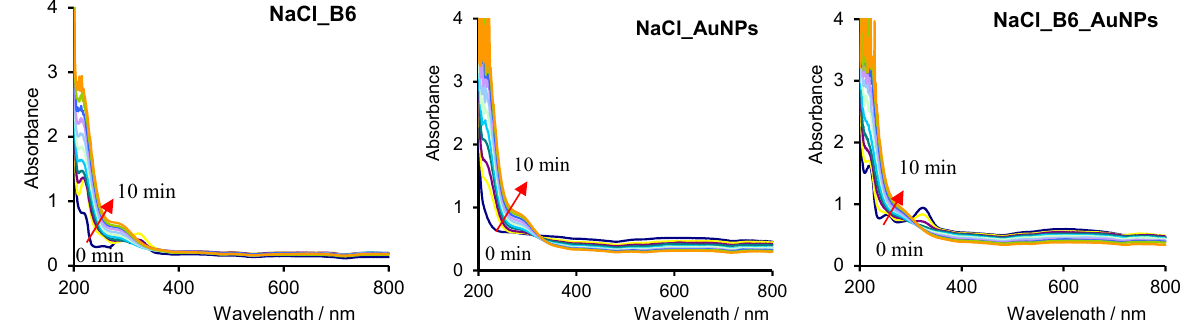
Figure 7. UV–Vis absorption spectra of sample as the electrochemical processes progress over time in NaCl/B 6 /AuNP systems (i = 50 mA × cm − 2 ).